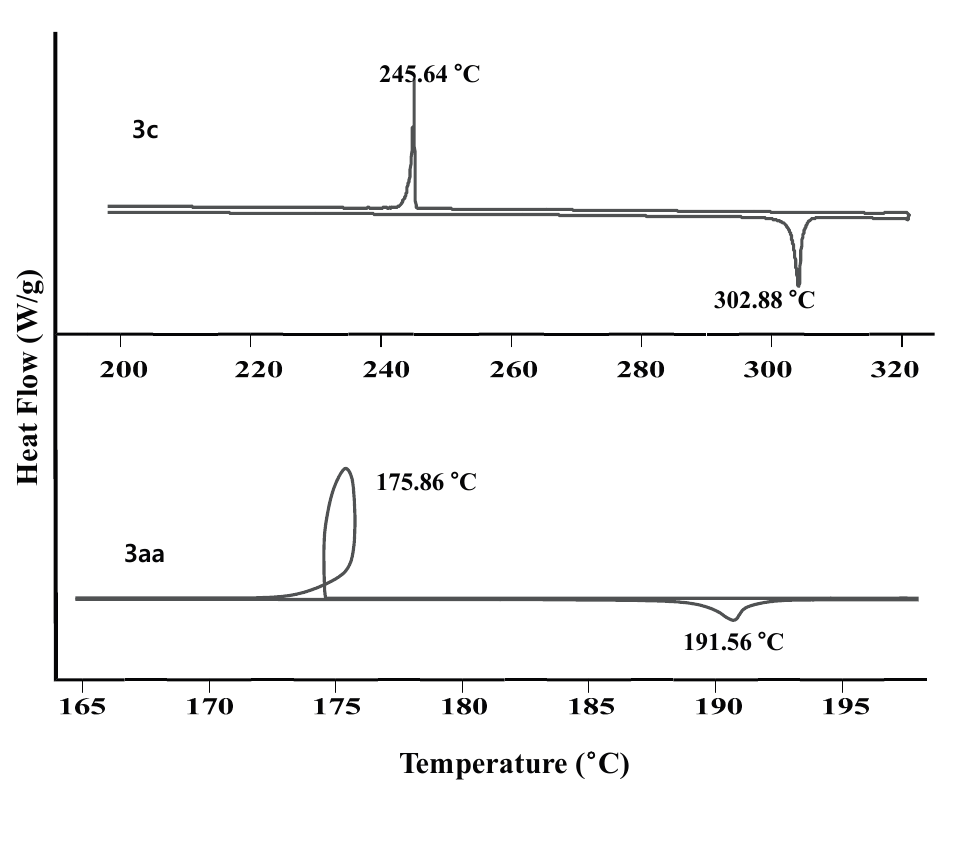
Figure 2. DSC of 3aa and 3c